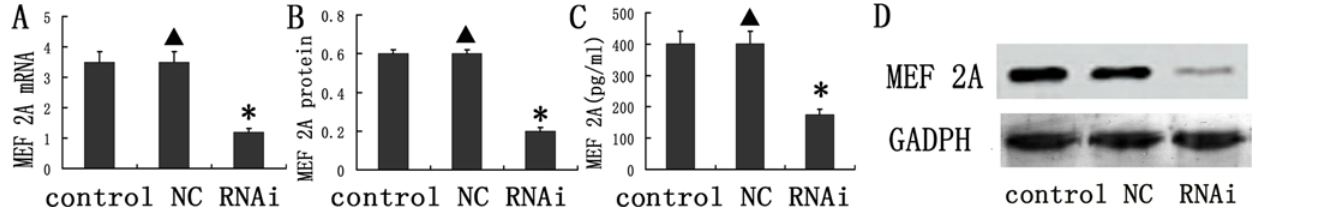
Fig 2. Knockdown of MEF 2A in vivo. (A) mRNA expression of MEF 2A in the plaques of the control, NC, and MEF 2A shRNA groups at week 10; (B) Protein expression of MEF 2A in the plaques of the control, NC, and shRNA groups; (C) The concentration MEF 2A in the plasma; (D) Representative Western blots used for quantification. Data are presented in the mean ± SD. * P < 0.05